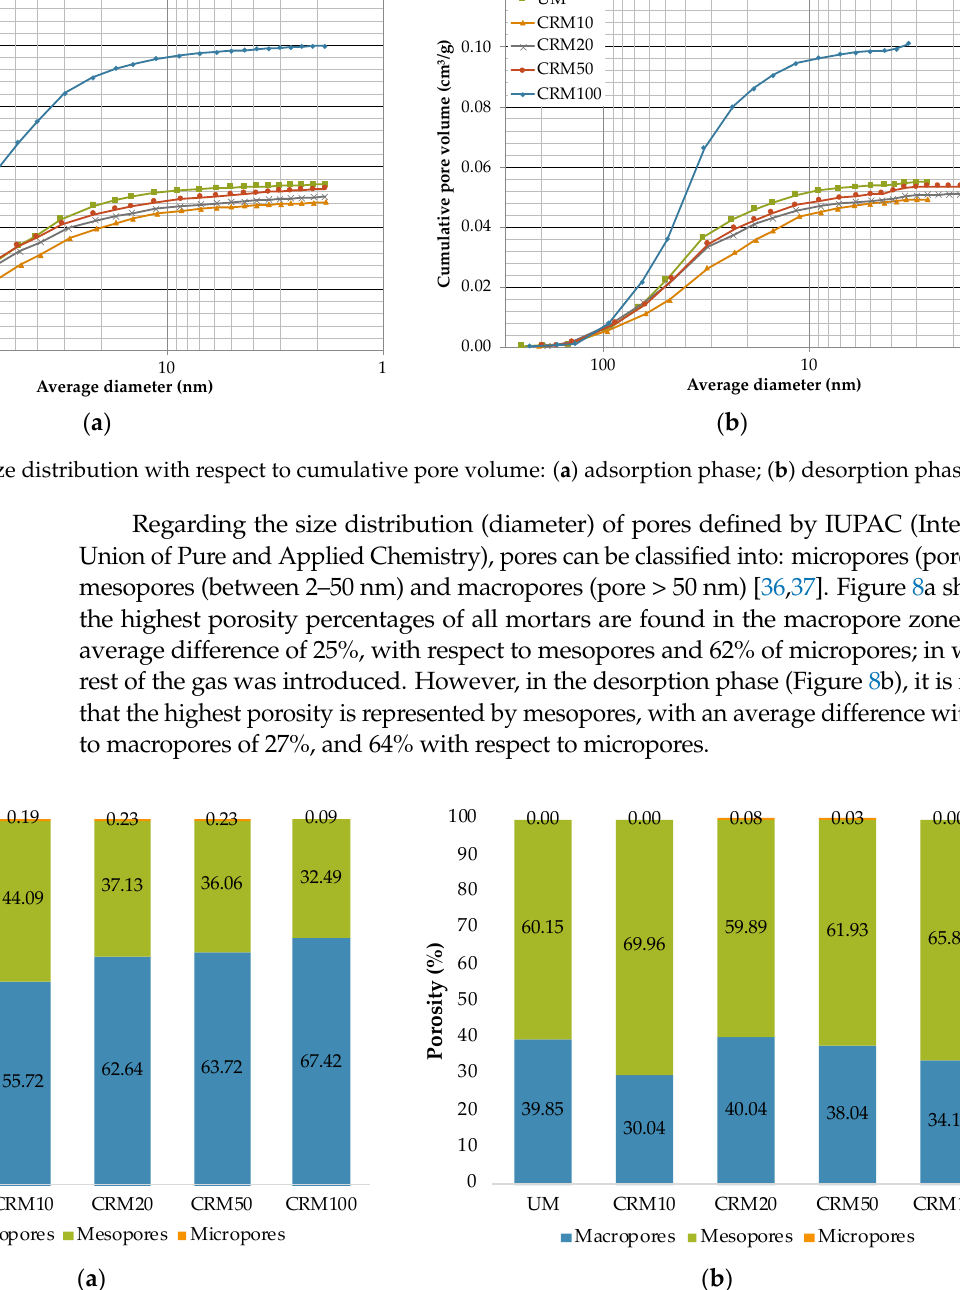
Table 5. Porosity measured in pore volume (N 2 adsorption and desorption phases). Mortar V ads (cm 3 /g) V des (cm 3 /g) UM